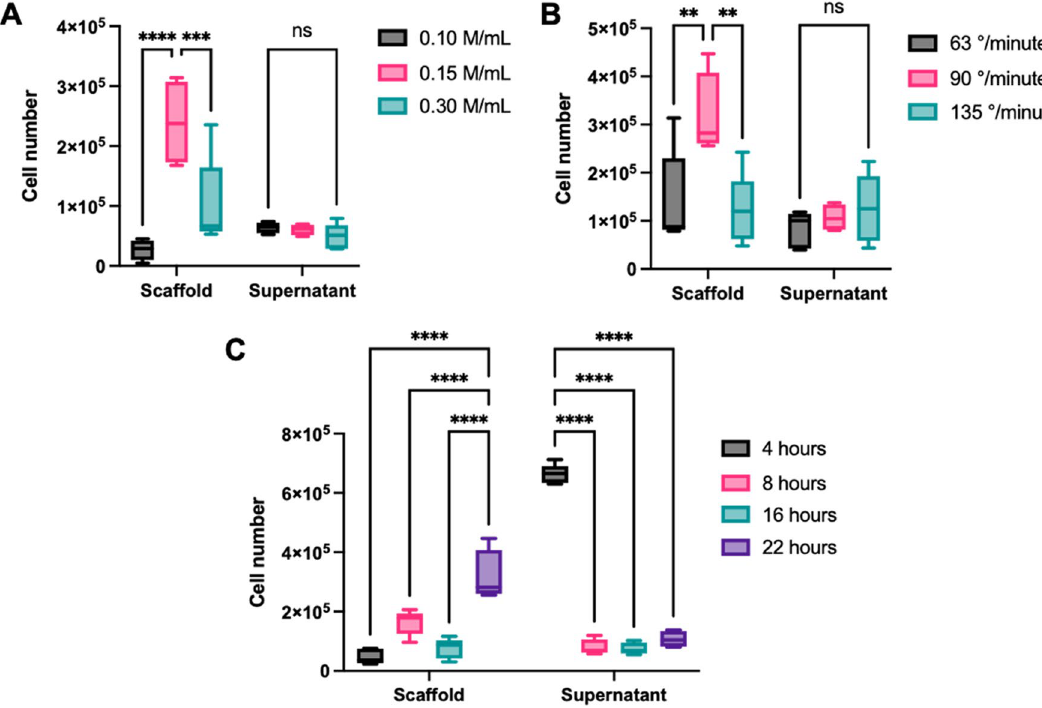
Figure 3. Number of cells adhered on the scaffolds and in the supernatant depending on cell concentration, speed of seeding system and incubation time. ( A ) Three cell concentrations in million cells per millilitre of medium (M/mL) were evaluated by seeding cells at 90°/minute for 22 h; ( B ) three system speeds (°/min) were assessed by seeding 0.15 M/mL cells for 22 h; ( C ) four incubation times (hours) were analyzed by seeding 0.15 M/mL at 90°/min. For statistical analyses, a two-way ANOVA with Tukey’s multiple comparison test was performed. Graph ( A–C ) show box and whiskers with max and min. n = 4–5/group. * P < 0.05, ** P < 0.01, *** P < 0.001 and **** P < 0.0001. ns